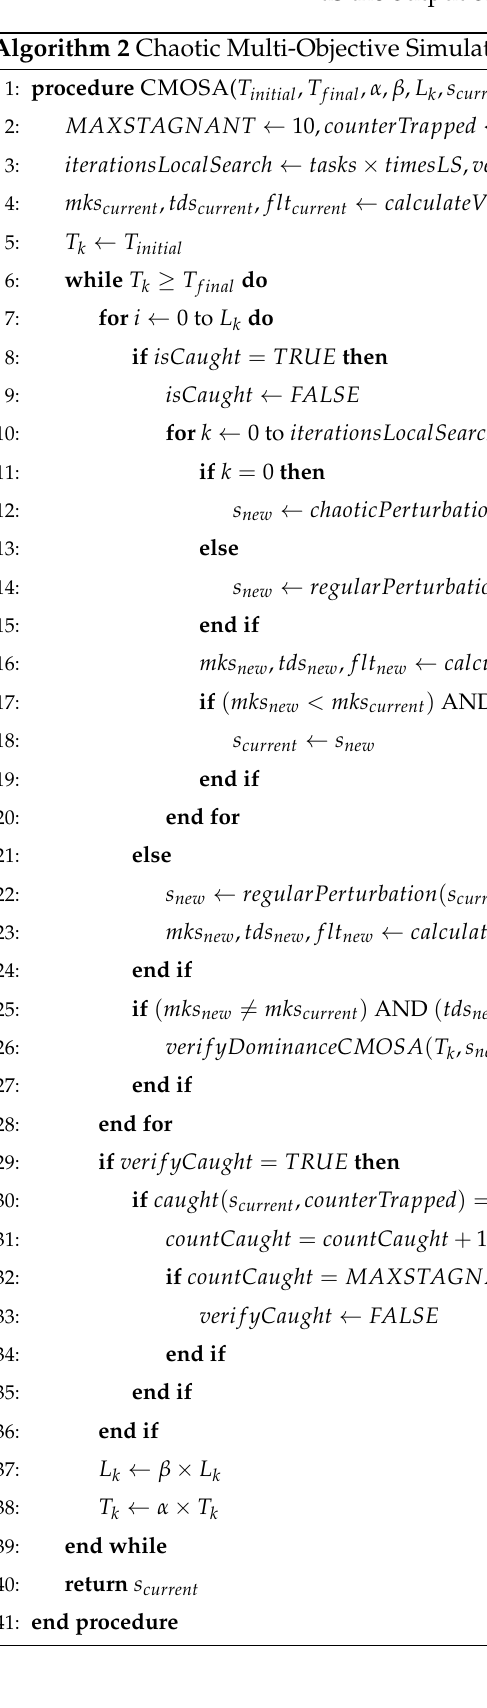
Algorithm 2 Chaotic Multi-Objective Simulated Annealing